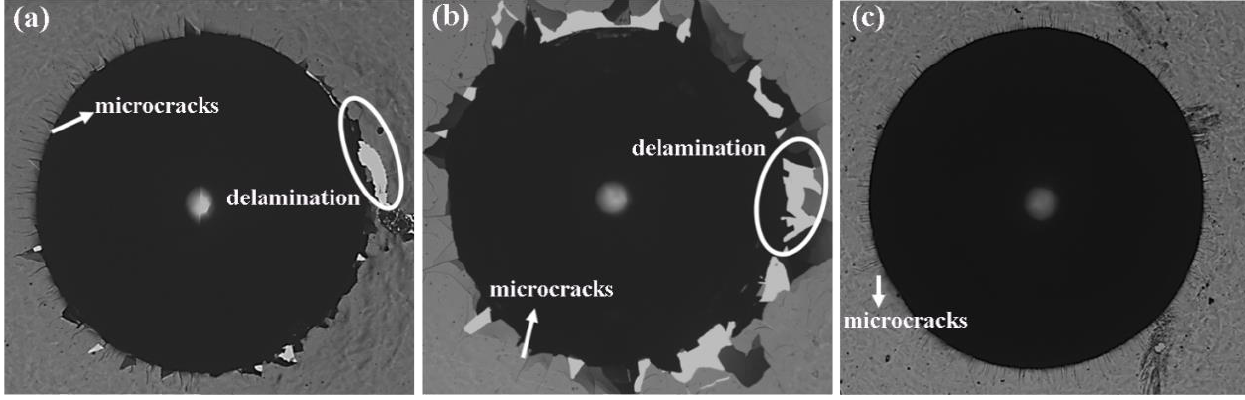
Figure 10. HRC indentation test of Ta coatings. ( a ) 200 °C-175 W, ( b ) 300 °C-150 W, and ( c ) 400 °C-100 W.